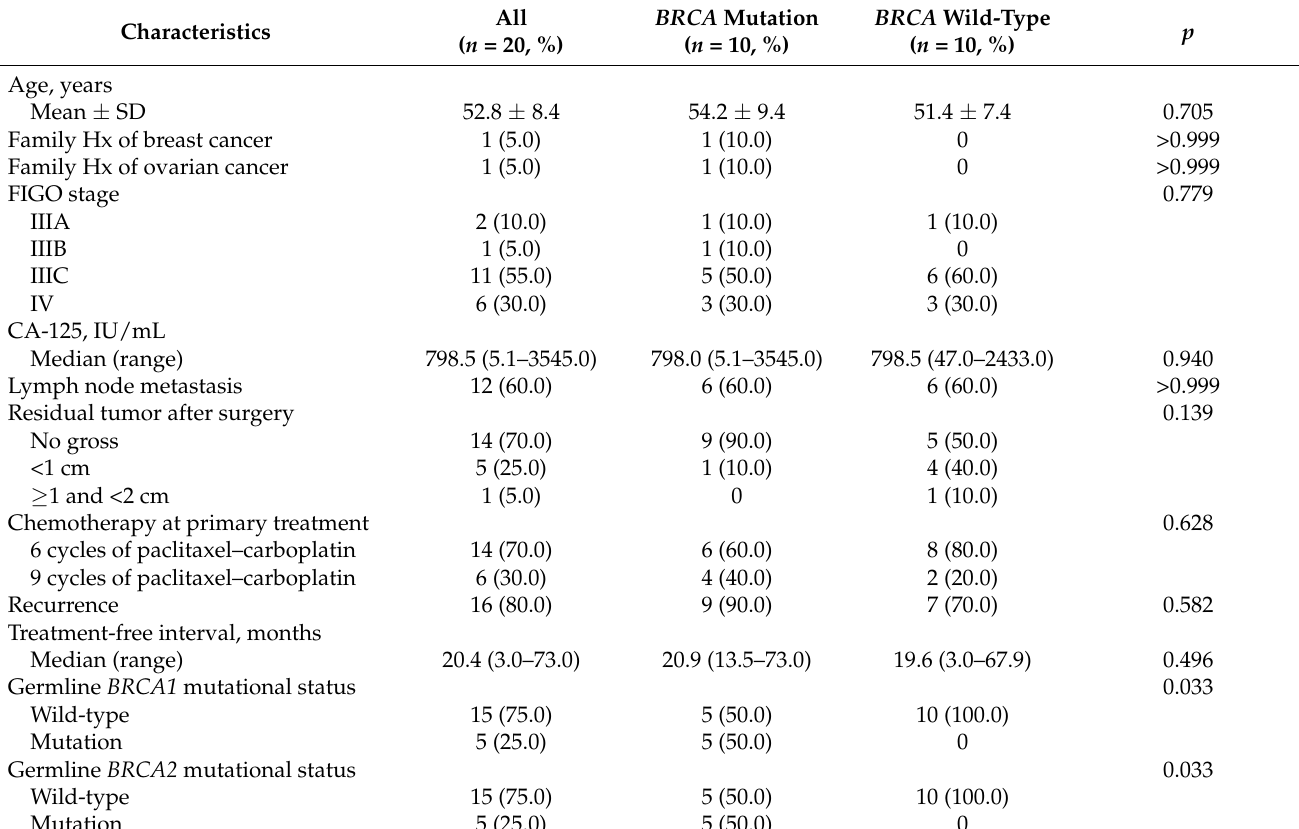
Table 1. Patients’ clinicopathologic